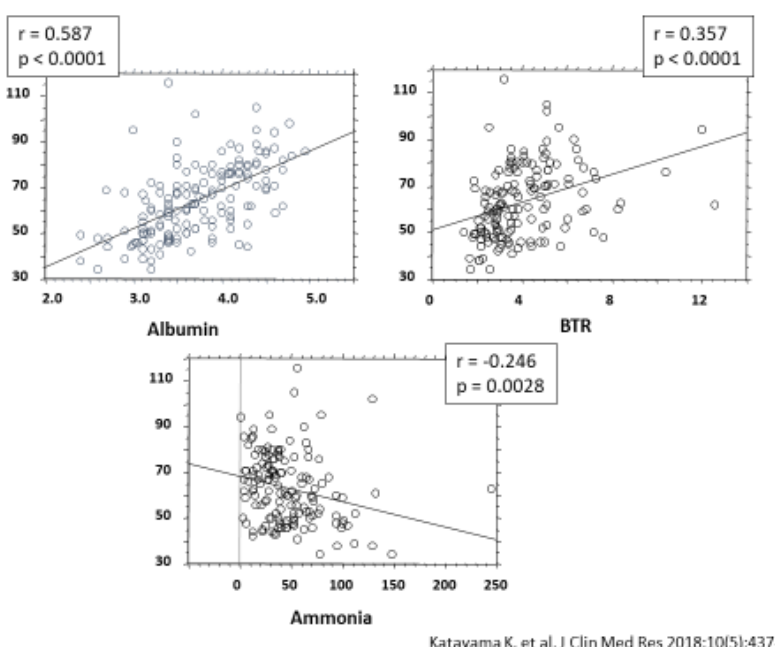
Figure 6. Relationship between serum zinc levels and Child–Pugh classification. A, Child-Pugh class A; B, Child-Pugh class B.; C, Child-Pugh class C.